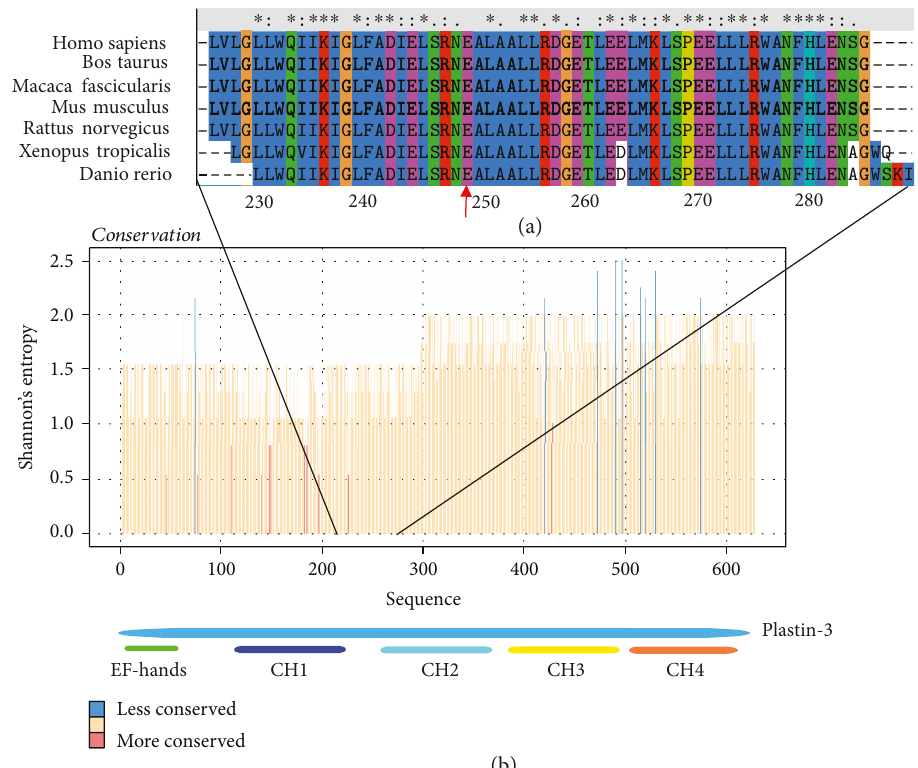
Figure 2: Sequence conservation in the plastin-3 family. (a) Local view of the multiple sequence alignment of plastin-3 in the neighbourhood of Glu249 (red arrow). (b) Whole plastin-3 plot. Conservation is represented using Shannon entropy, a parameter routinely used for scoring pathogenic mutations, whose values range from 0 (complete conservation) to 4.32 (all amino acids are equiprobable at that